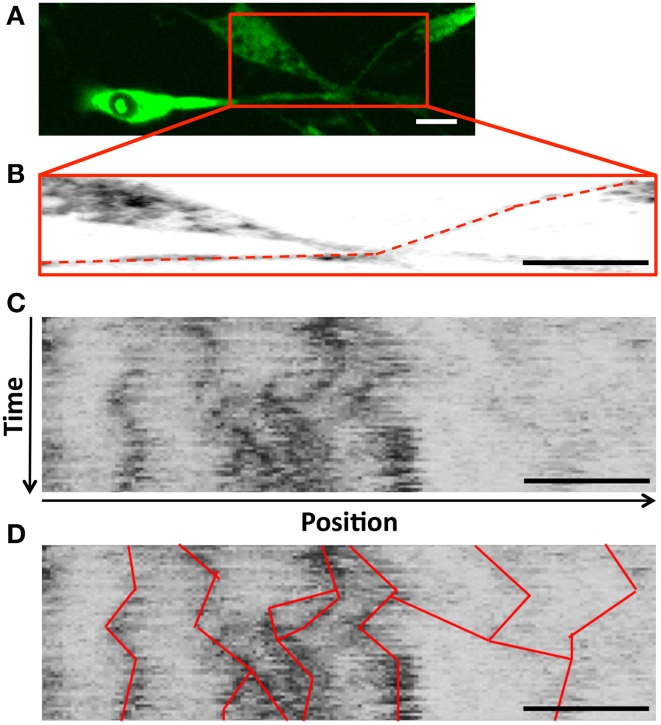
(A) Schwann cell projections were cropped and traced to develop (B) Sample trace (dashed line) used to develop a kymograph (C) a kymograph (y-axis: time, increasing downward; x-axis: position along the projection, with anterograde to the right); (D) Trajectories for puncta observed in consecutive frames were traced on the kymograph to identify ribosomal movement throughout the projection, and allow for quantification of transport parameters during the course of the experiment; Scale bar: 20 μm, duration 5 min.